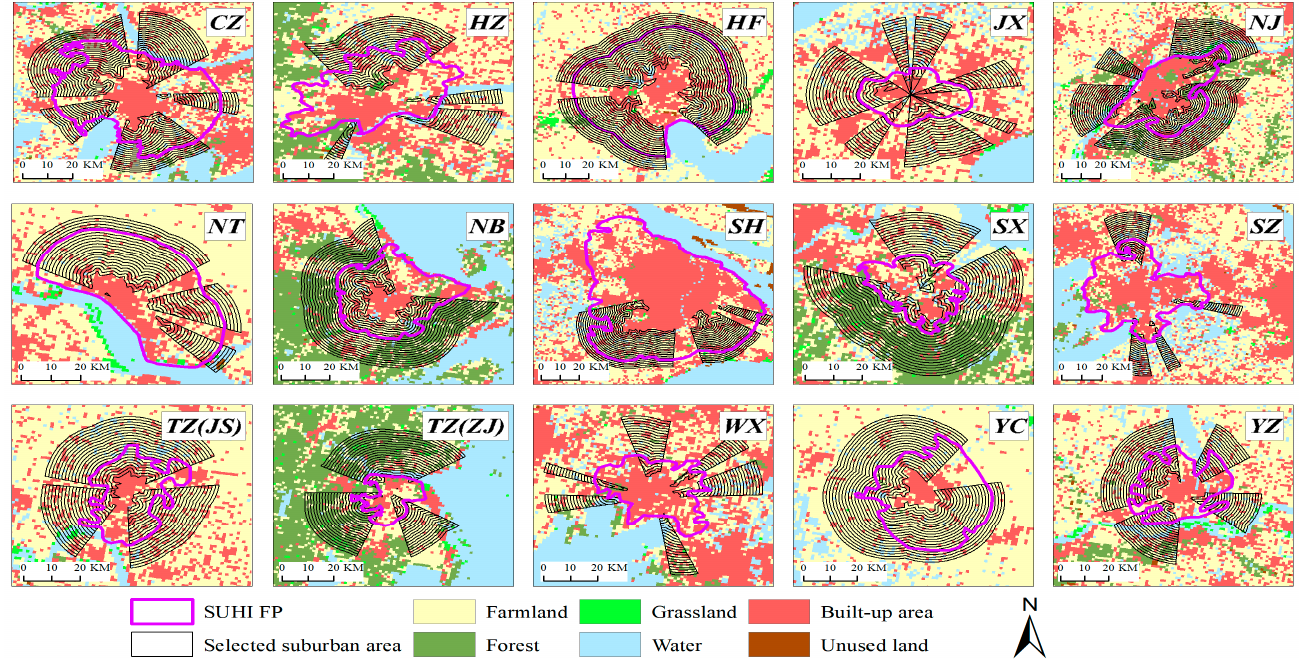
Figure 4. Selected suburban areas and the surface urban heat island footprints of 15 cities.